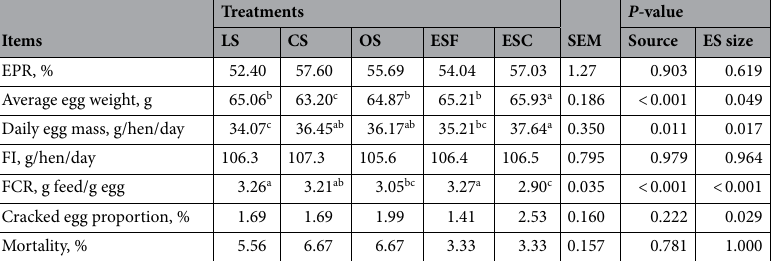
Table 1. Overall performance of laying hens according to the dietary treatments between 73 and 80 week of age. Results are the means of 10 replicates of 9 hens each per treatment for the 7-wk experimental period. LS limestone (< 2 and 2–4 mm mixed in 3:7); CS cockle shell (1–4 mm); OS oyster shell (3–16 mm); ESF eggshell fine particles (< 1 mm); ESC eggshell coarse particles (3–5 mm). SEM standard error of means, ES eggshell, EPR egg production rate, FI feed intake, FCR feed conversion ratio. a-c Means with the different superscript in the same row differ significantly ( P <